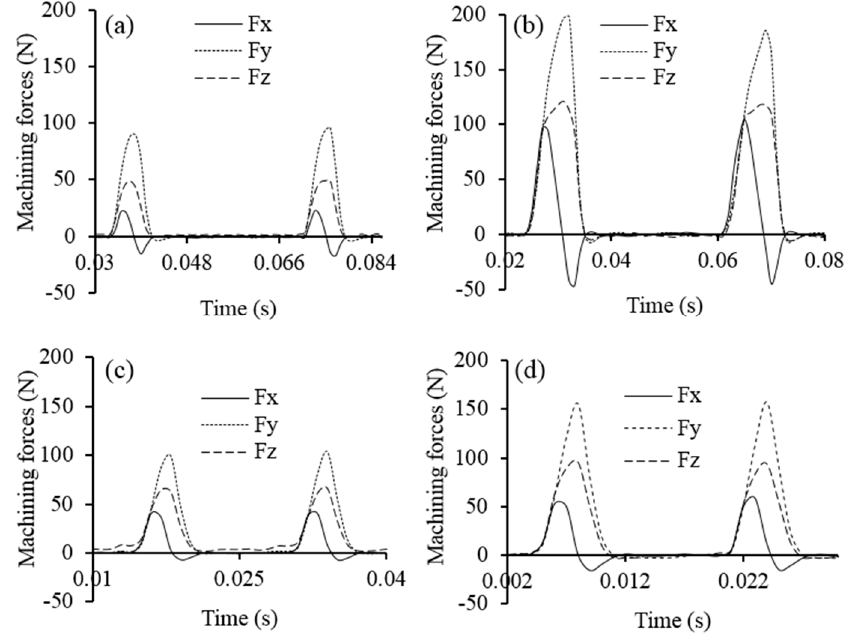
Figure 8. Force signals in different conditions: ( a ) 60 mm/min speed, 0.025 mm/tooth feed; ( b ) 60 mm/min speed, 0.075 mm/tooth feed; ( c ) 140 mm/min speed, 0.025 mm/tooth feed and ( d ) 140 mm/min speed, 0.075 mm/tooth feed.